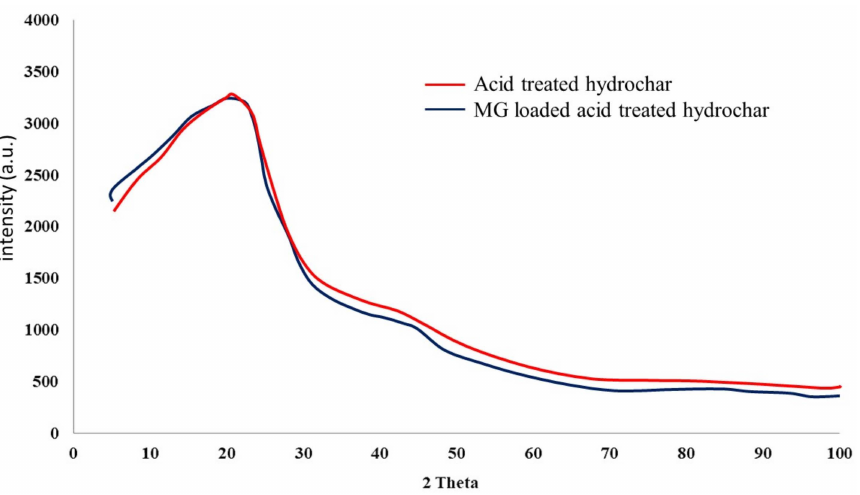
Figure 7. X-ray diffraction pattern of citric acid treated hydrochar and MG loaded citric acid treated hydrochar.